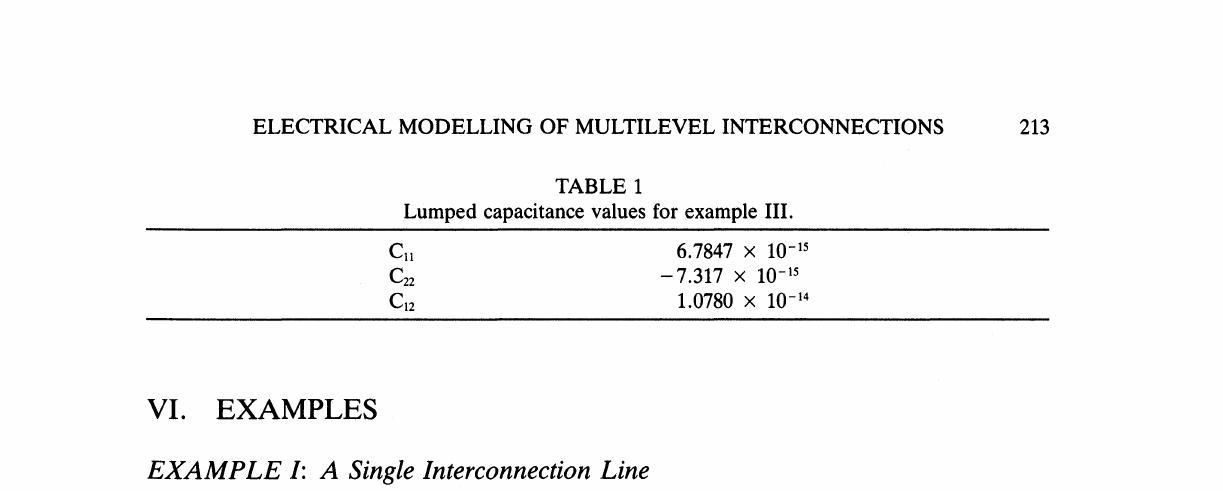
Lumped capacitance values for example III.